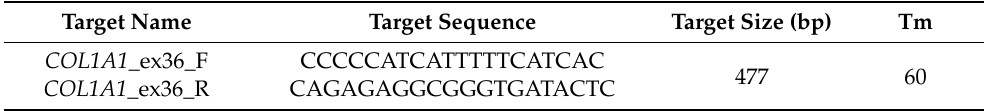
Table 4. sgRNA target site